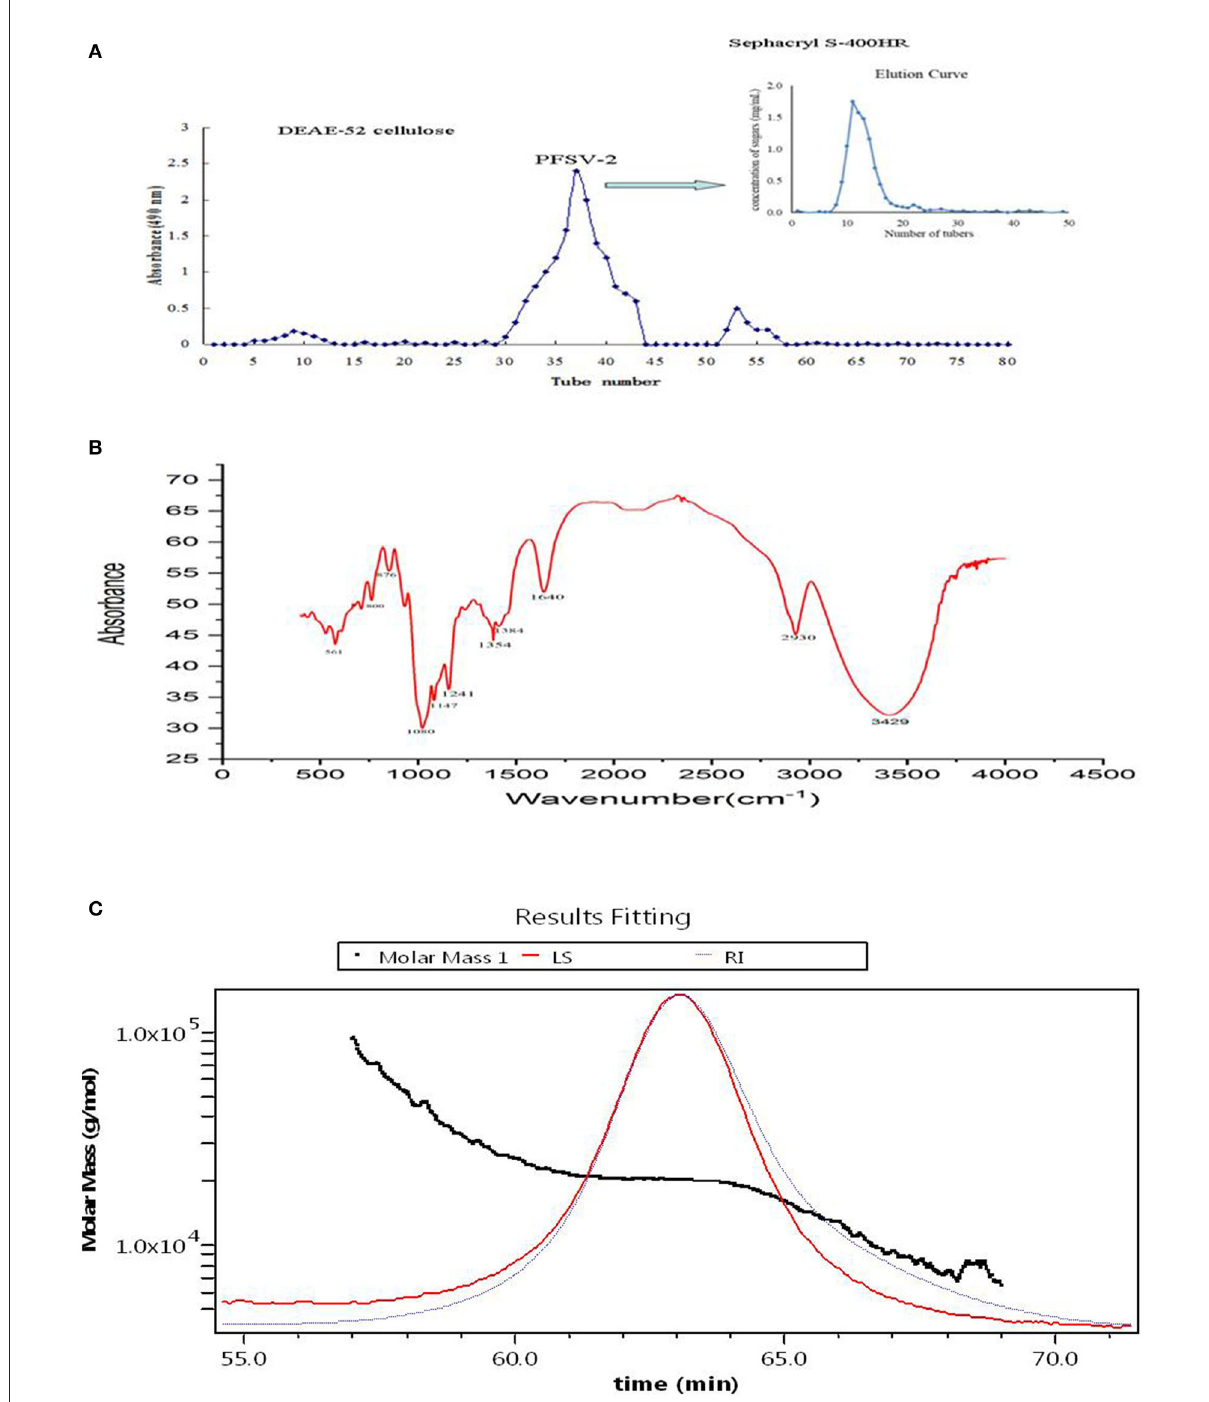
FIGURE2 Elution curve of crude PFSV on DEAE-52 cellulose and sephacryl S-400HR chromatography column (A) ; FT-IR spectrum of PFSV-2 (B) ; and chromatograms of the molar mass distribution of PFSV-2 (C)